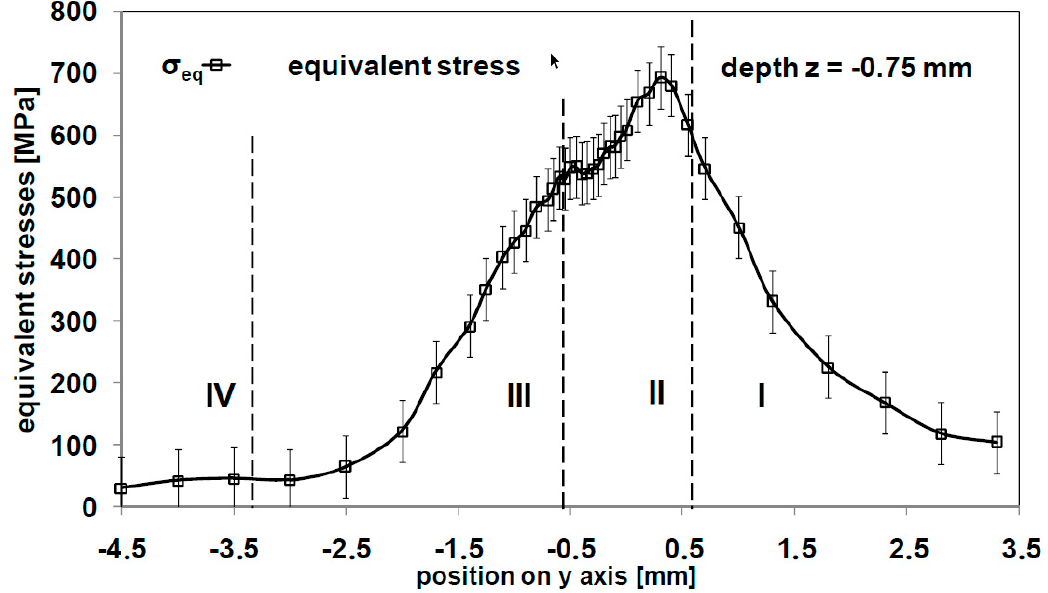
Figure 9. Plot of equivalent stress ( σ eq ) evolution at the depth of residual stress compensation at z = − 0.75 mm for 3900 N load.